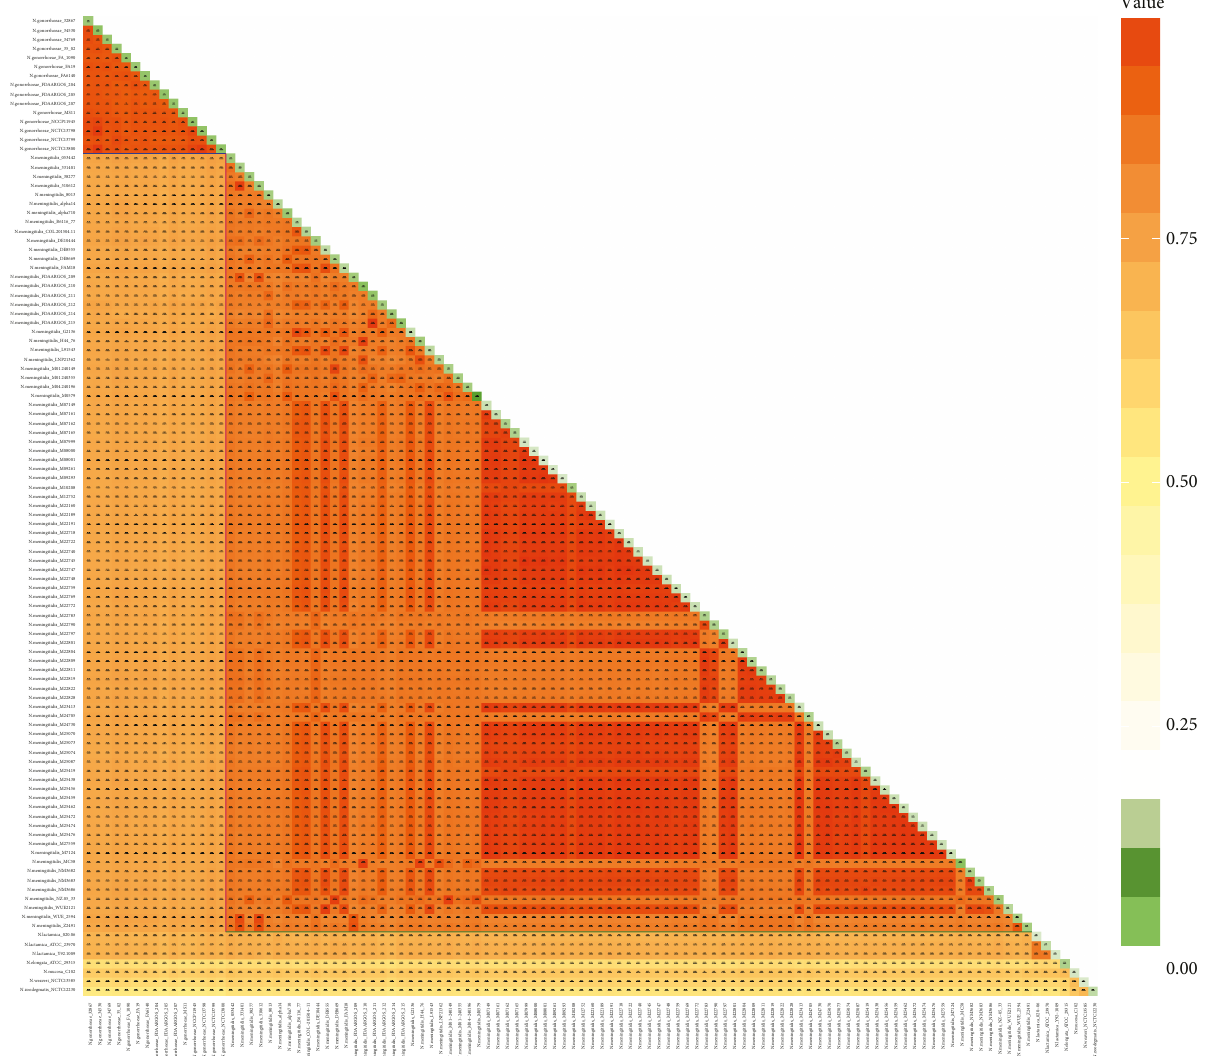
Figure 1: Homologous proteome analysis between di ff erent strain proteomes (orthologous) and within a strain proteome (paralogous). The percentages of orthologous and paralogous proteins were represented by orange and green, respectively. The color depth corresponded to the size of homologous proportion. The ratios of homologous were shown in both corresponding boxes and Table